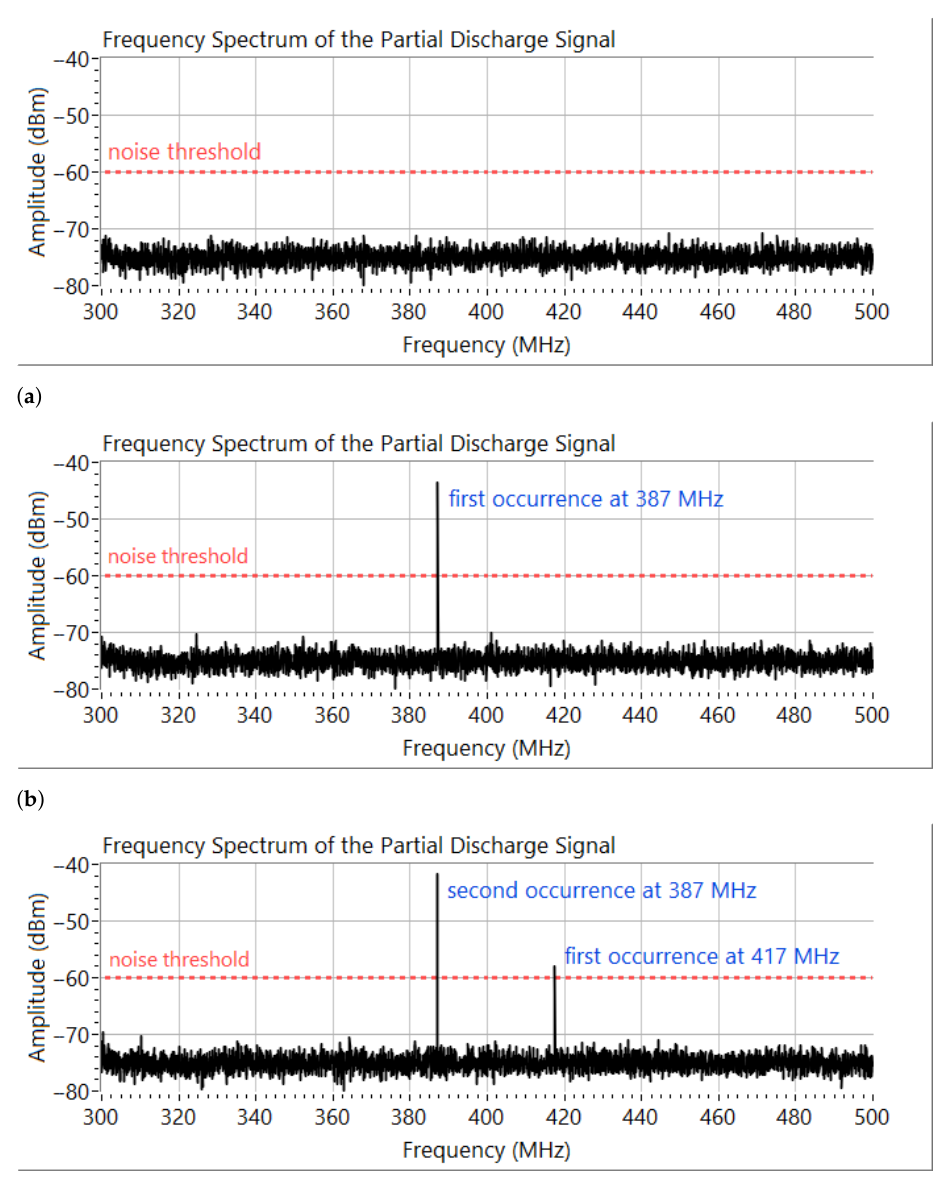
Figure 7. Spectral registering of PD pulses obtained at different times: ( a ) measurement with no occurrence records, at t = t 0 ; ( b ) detection of the first occurrence at 387 MHz, at t = t 1 ; and ( c ) detection of the second occurrence at 387 MHz and of the first occurrence at 417 MHz, at t = t 2